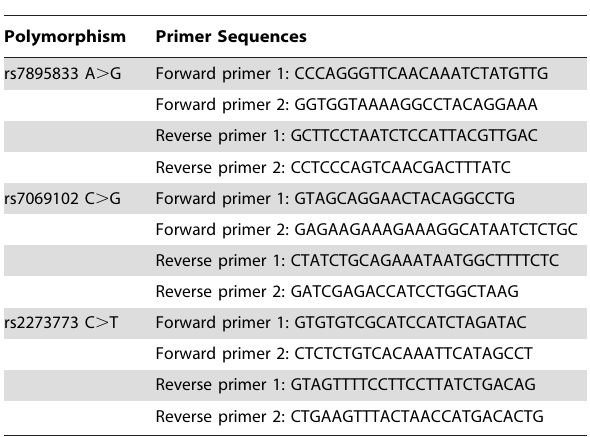
Table 1. Primer sequences in SIRT1 gene polymorphisms.